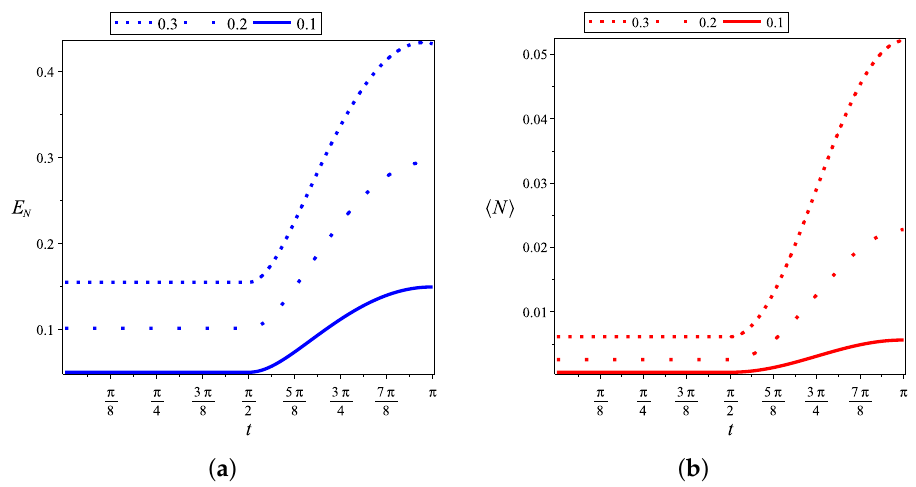
= 1, we display for three different values of USC Figure 6. For the resonant case (cid:101) = 0 and fixed ω 2 0 coupling J 0 = 0.1,0.2 and 0.3, shown on the top of the figures, ( a ) the dynamics of entanglement quantified by logarithmic negativity E N and ( b ) VE (cid:104) N 1 (cid:105) = (cid:104) N 2 (cid:105) = (cid:104) N (cid:105) .